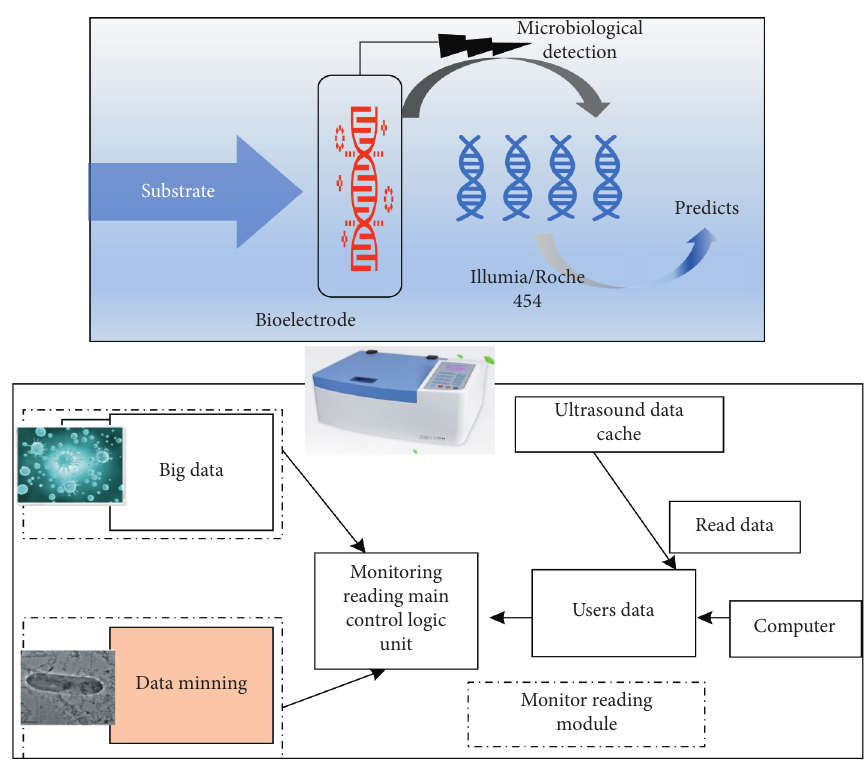
Figure 2: General structure framework of water microbial concentration monitoring system.